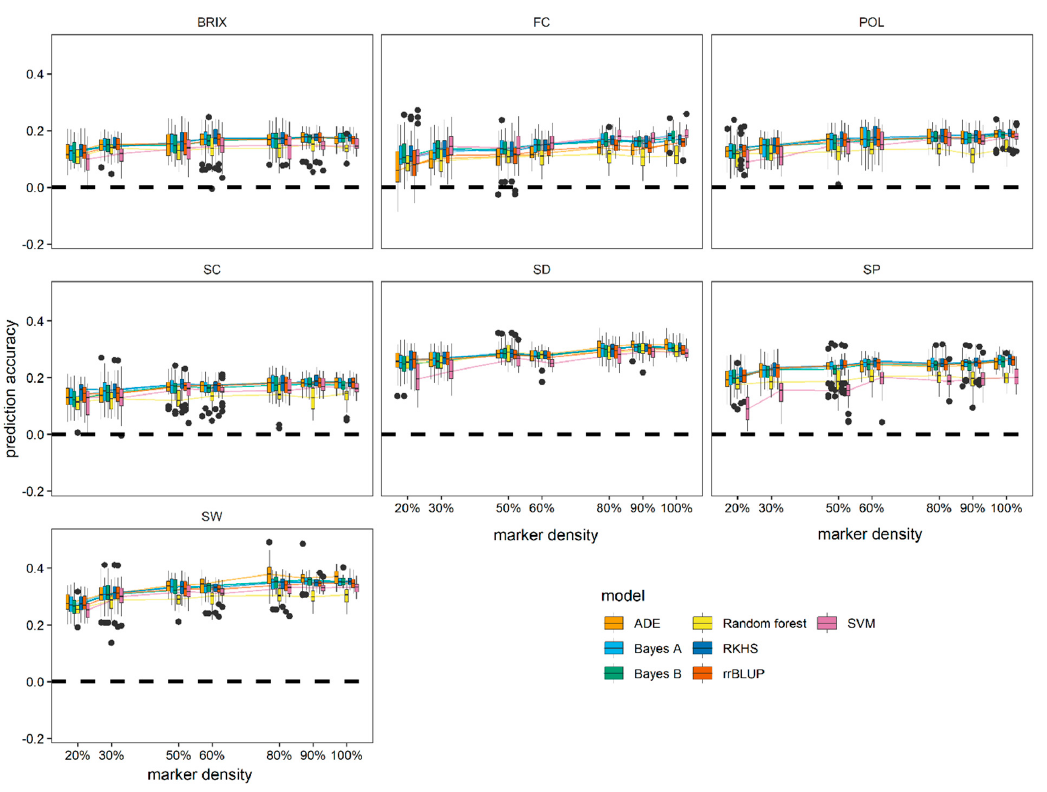
Figure 5. Fivefold cross-validated prediction ability for seven yield- and sugar-related traits: Brix, fiber content (FC), pol, sucrose content (SC), stalk diameter (SD), stalk population (SP), and stalk weight (SW) in sugarcane based on seven different genomic selection models and marker density. The plant cane phenotypic data were used.